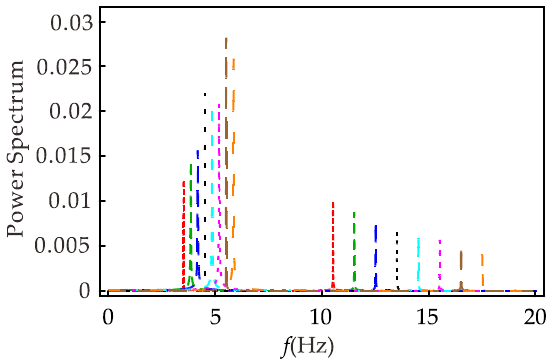
Figure 10. Spectrum diagram of 1/3 subharmonic resonance at different excitation frequencies.